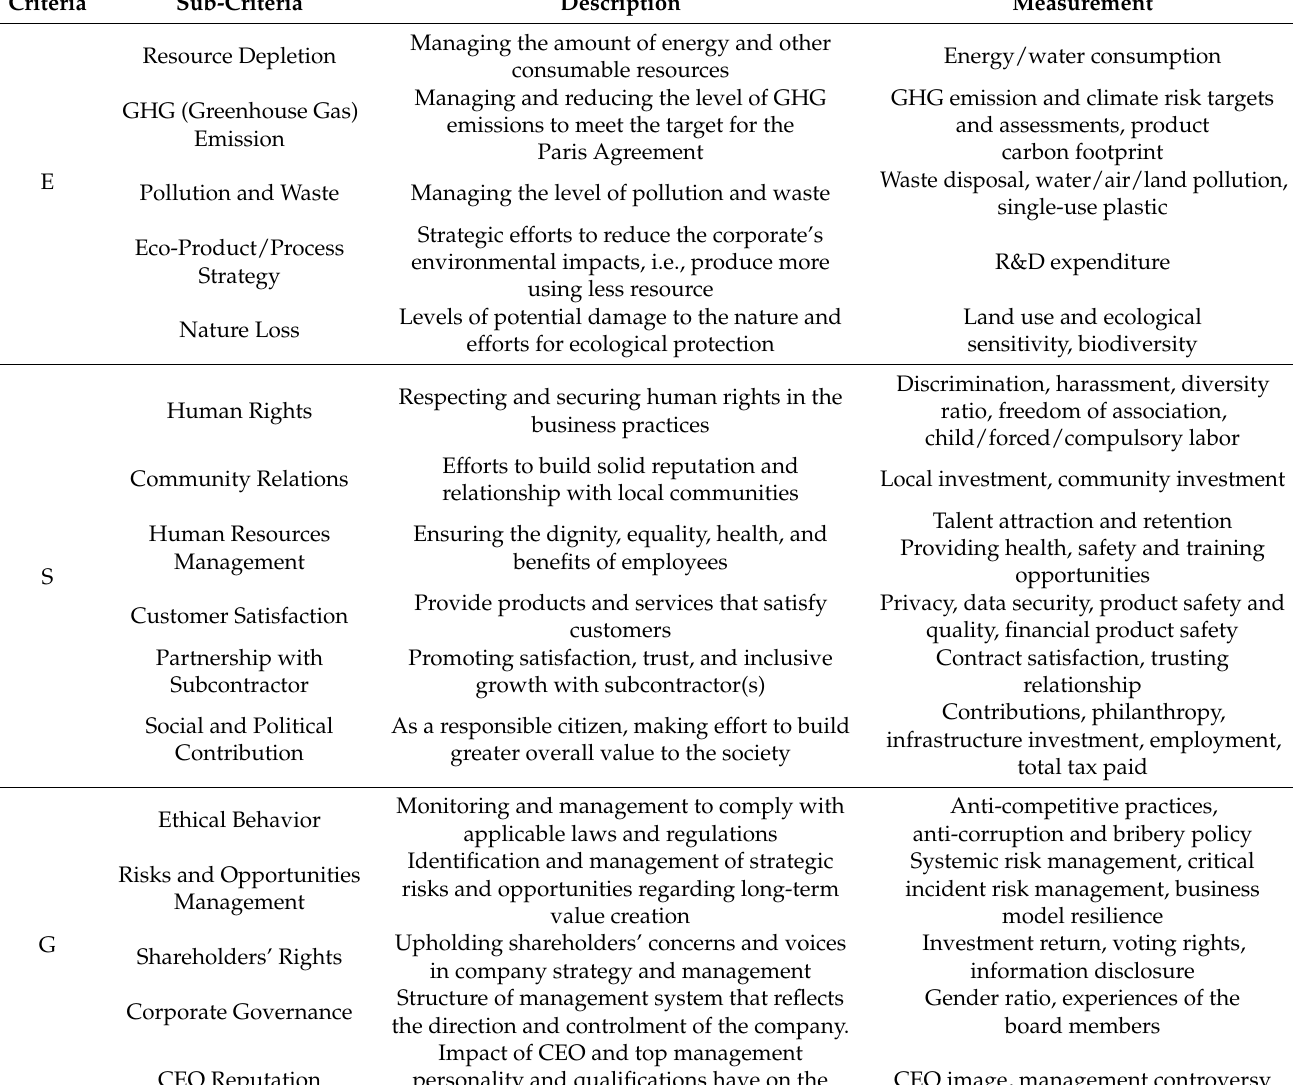
Table 2. Description by